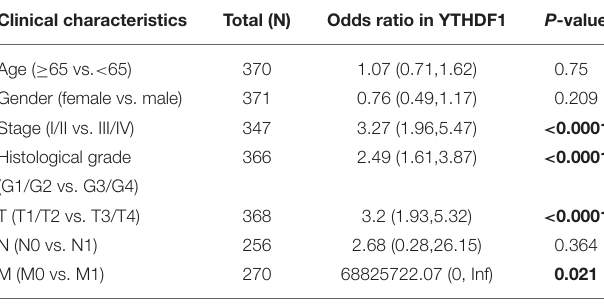
TABLE 4 | Univariate analysis and multivariate analysis of recurrence-free survival in HCC patients from TCGA. Parameters Univariate analysis Multivariate analysis CI